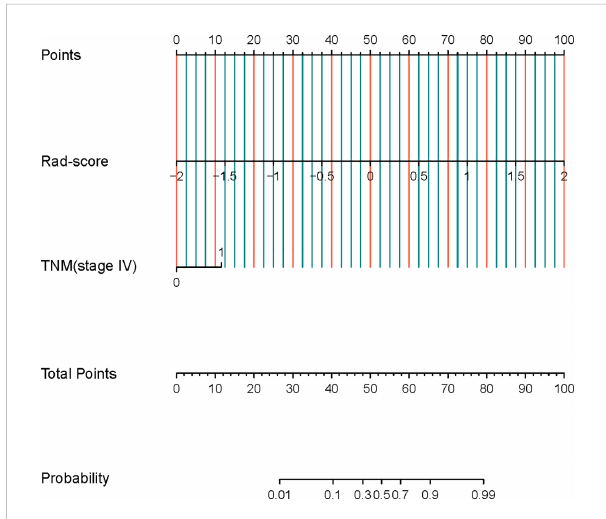
FIGURE 4 Radiomics nomogram constructed based on clinical model and radiomics signature.